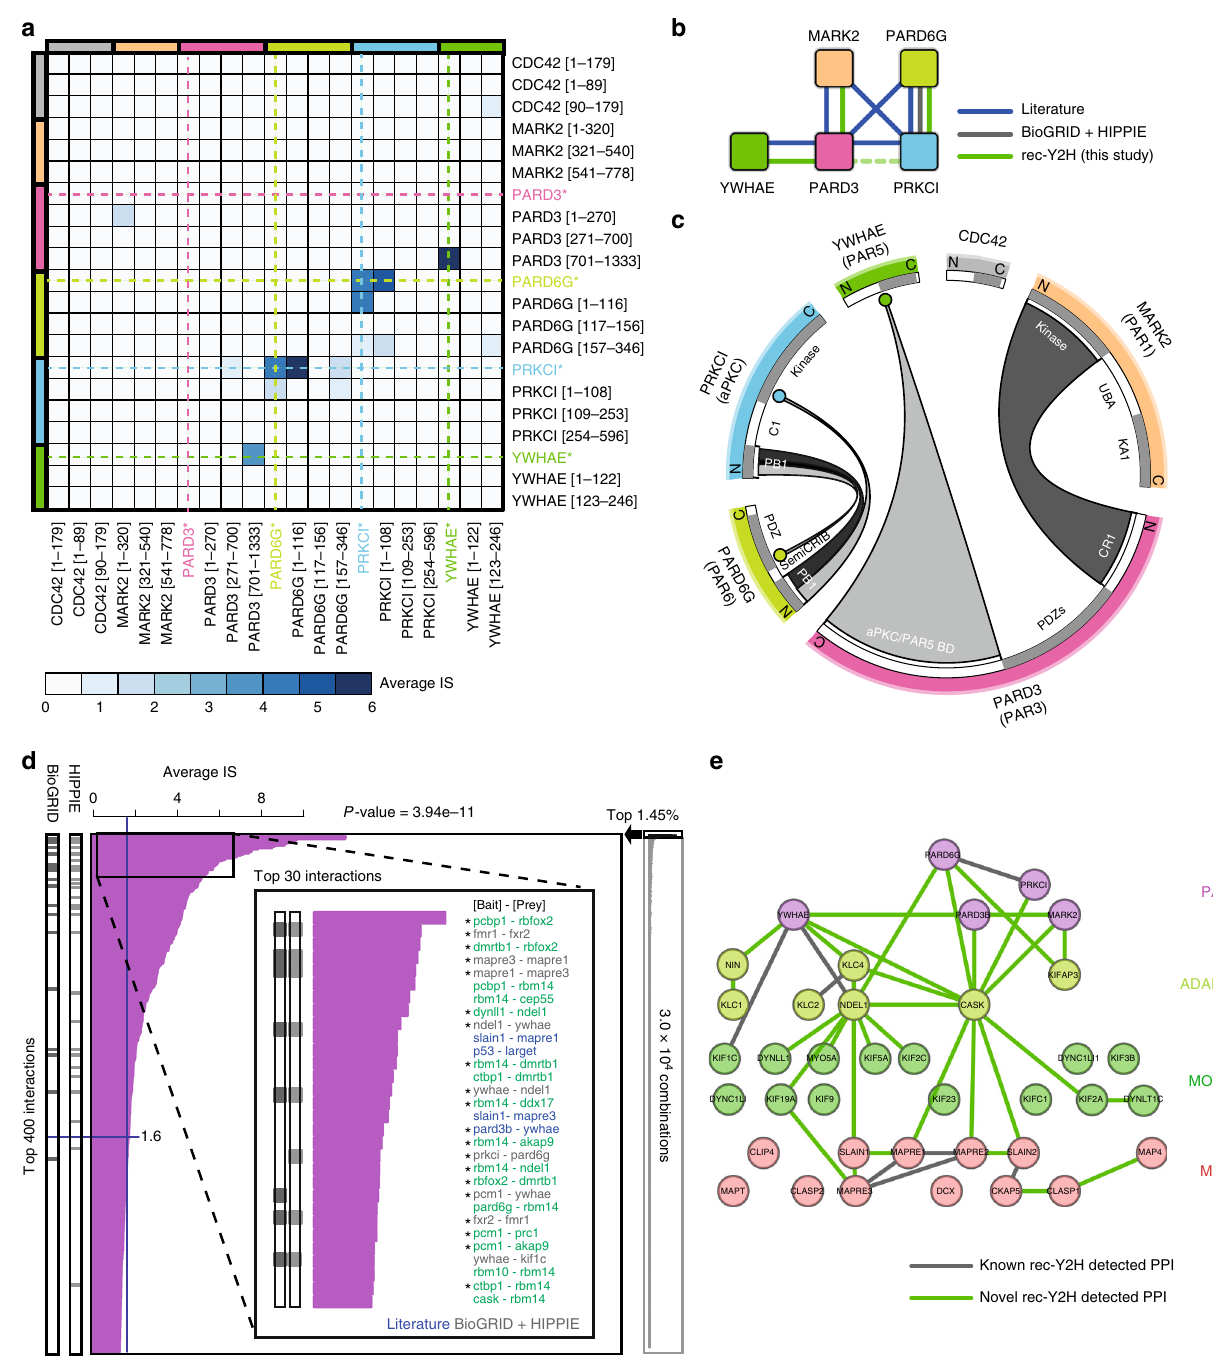
Fig. 4 Simultaneous mapping of interactions between PAR protein domains. a Matrix showing the average IS between full-length PAR proteins and their domains. b Interaction scheme for full-length PAR proteins based on interactions from the literature, PPI databases, and data from our rec-Y2H screen. Dotted line between PARD3 and PRKI indicates that the average IS (0.95) for this interaction was below our cut-off of 1.6 (based on F1-Score; see Supplementary Fig. 11). c Circular representation of the detected interactions involving PAR protein domains. Coloured circles situated in the middle of a protein represent interactions between a PAR protein domain and a full-length protein. Interactions detected between two full-length proteins (shown in a ) have been omitted for clarity. d Top 400 protein pairs with the highest average IS compared to interactions annotated in PPI databases. P -value indicates how many known PPI are enriched in top 400 by hypergeometric test. The top 30 pairs are further highlighted in the inset box. Among them, nine are found in PPI databases (grey), and four are positive controls or literature-curated interactions (blue). Among the newly found 17 pairs (green), 11 pairs were detected in both orientations (Px-AD — Py-BD or vice versa, marked with asterisk), and are thus of high con fi dence. The rightmost box indicates the possible 3.0 × 10 4 interaction pair combinations. e Interaction hierarchy of the PAR-MAP network. All the interactions depicted here were detected by rec- Y2H. Interaction pairs also annotated in the PPI databases are shown as grey